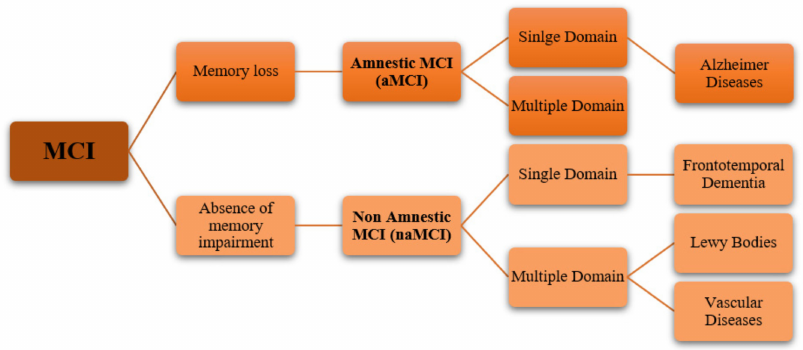
Figure 2. Schematic representation of MCI